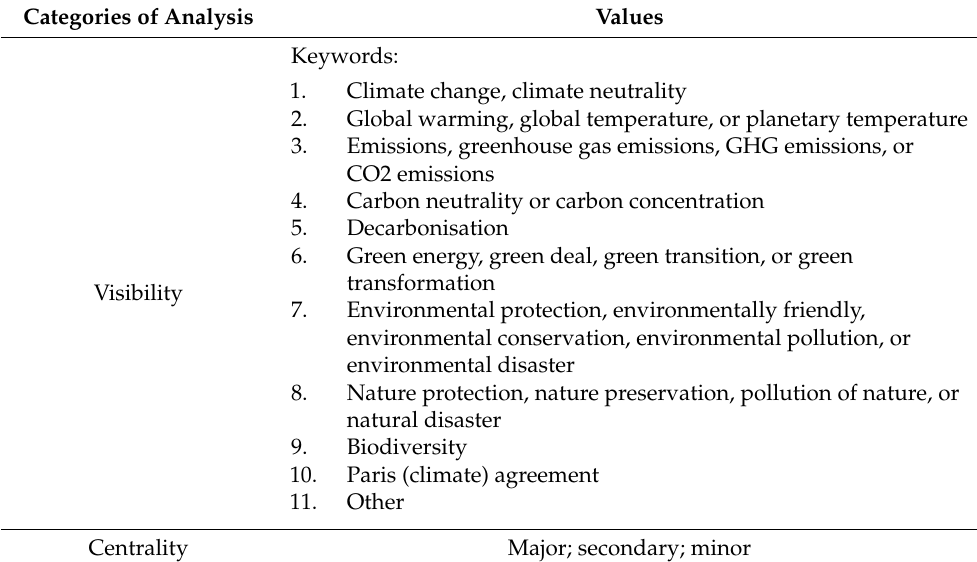
Table 1. A codebook for the analysis of political party programmes. Categories of